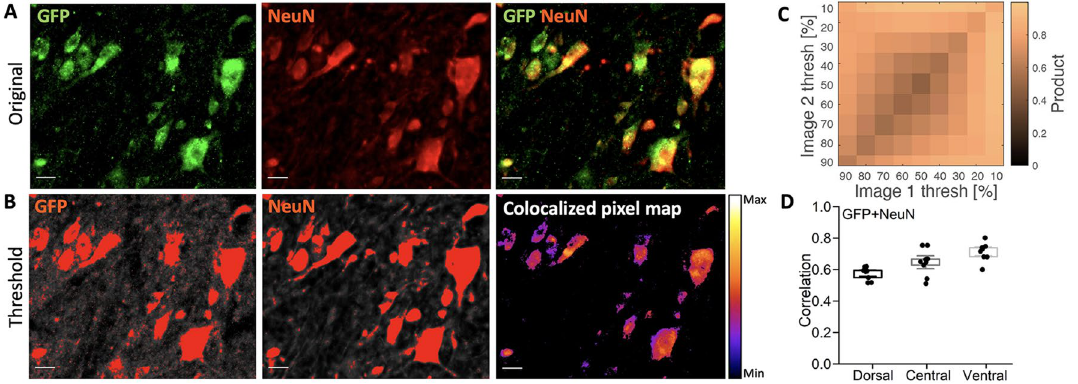
Figure 8. AAV9-hSyn1-driven infection correlation with NeuN biomarker. ( A ) Top row: expression of GFP with hSyn1 promoter has high overlap with the NeuN staining. ( B ) Threshold and co-localization in a heat map. ( C , D ) The co-localization is quantified for different thresholds and across the three regions. Scale bar 20 µ m. N = 3 animals, n = 3